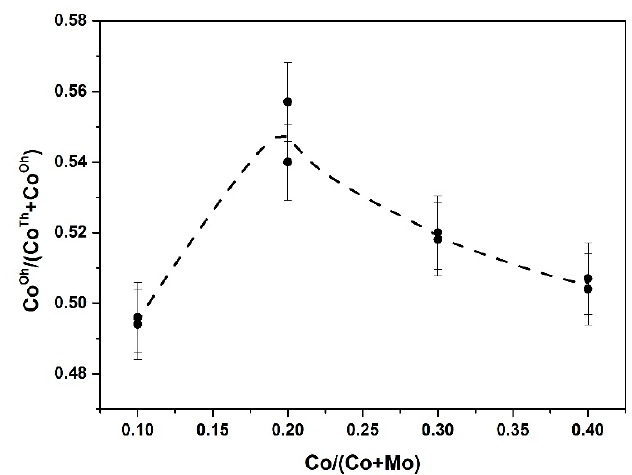
Figure 9. Correlation between Co Oh and Co loading of the promoted CoMo catalyst with 10 wt.% and 15 wt.% Mo calcined at 673 K.